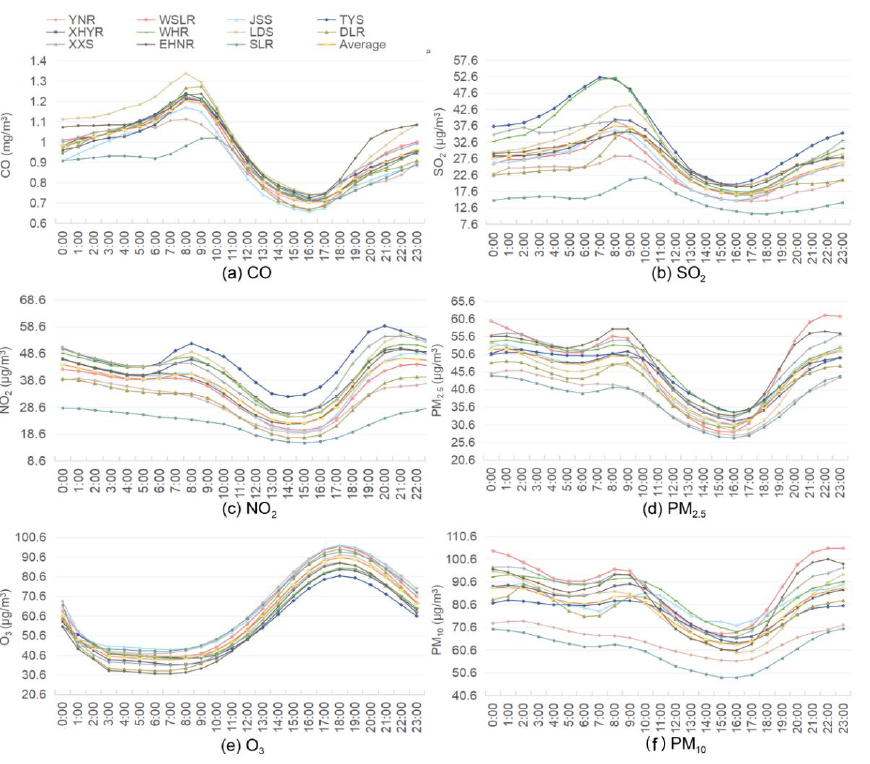
Figure 6. Diurnal variation of concentrations of six pollutants from 2017 to 2019: ( a ) CO, ( b ) SO 2 , ( c ) NO 2 , ( d ) PM 2.5 , ( e ) O 3 , ( f ) PM 10 .